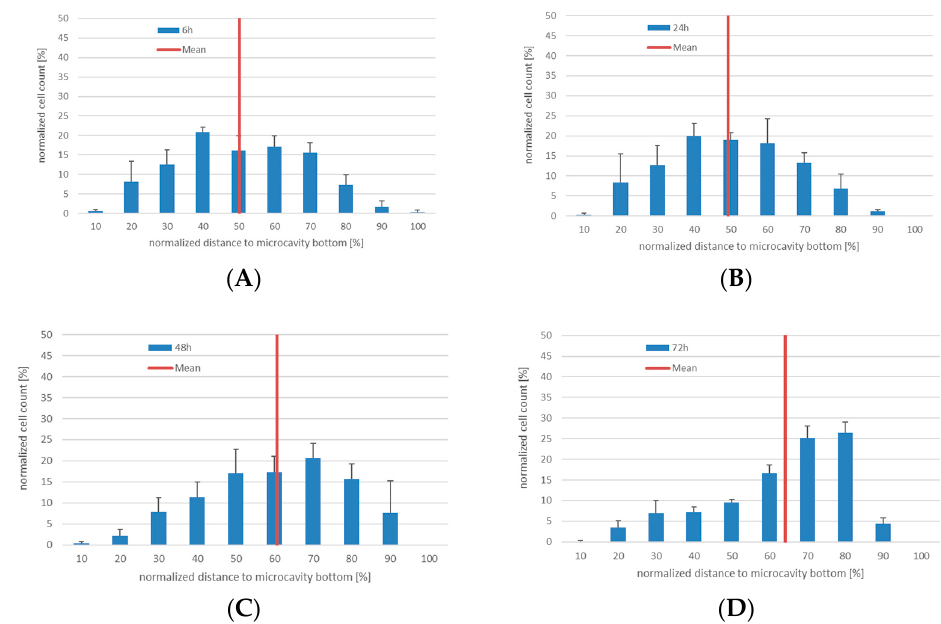
Figure 3. 3D co-culture of KG-1a with Hep G2 cells in microcavities. Number of CellTracker TM Green positive cells (CTG + ) and their position relative to the cavity bottom (100%) at 6 ( A ), 24 ( B ), 48 ( C ), and 72 h ( D ), respectively. The mean is displayed as a red line, n = 3.